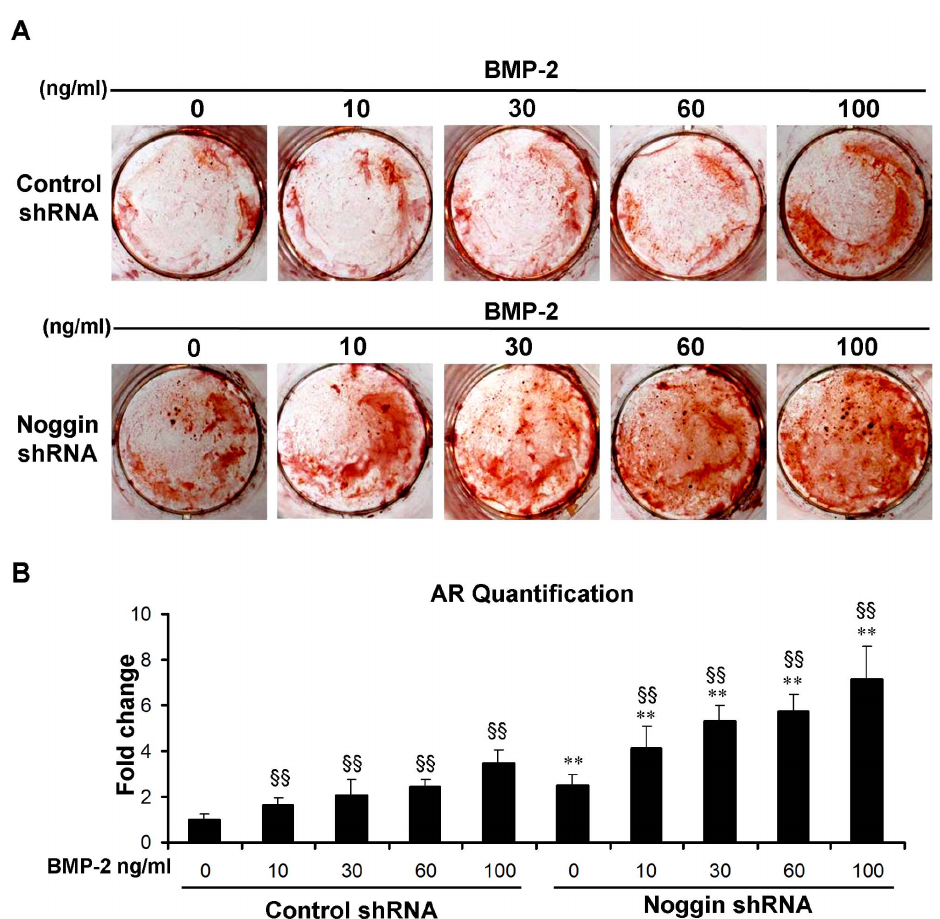
Figure 3. Mineral formation of ASCs in monolayer culture. Mineralization was increased in ASCs transduced with noggin shRNA in the presence or absence of BMP-2 as assessed by Alizarin red staining (A) and quantification (B) at day 14. (** p , 0.01 compared to their corresponding controls transduced with control shRNA). Significantly more staining was observed after treatment with different doses of BMP-2 ( 11 p , 0.01).